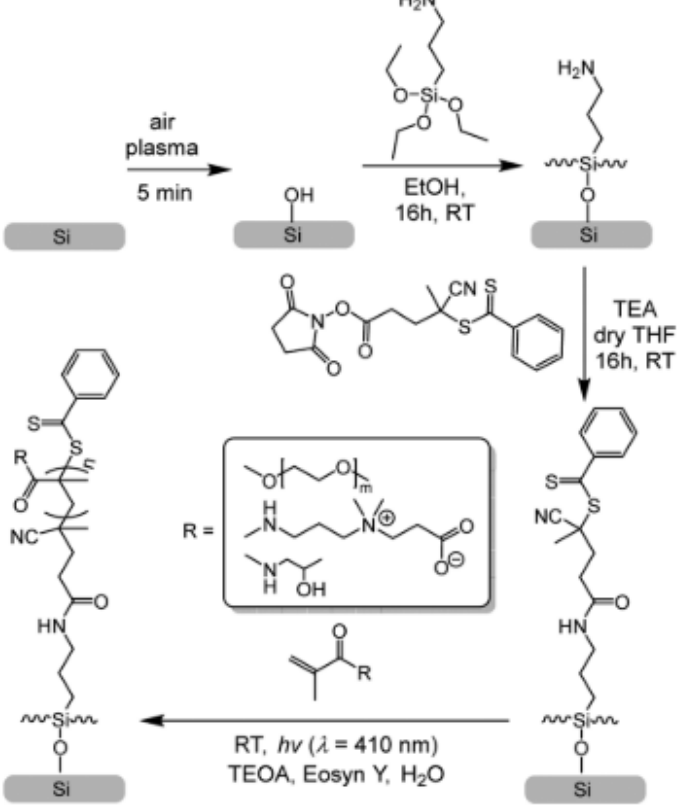
Figure 19. Reaction scheme to produce antifouling surfaces. Reproduced with permission from ref. [111].